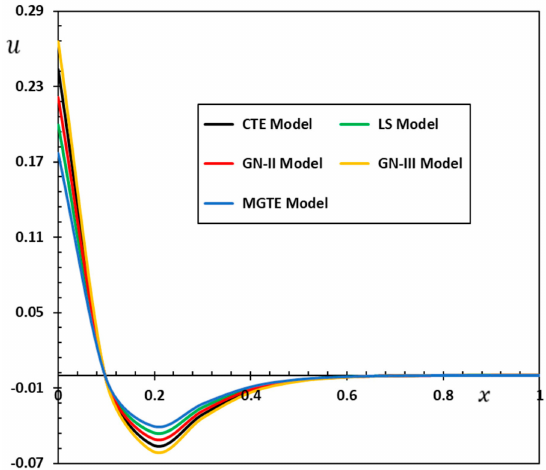
Figure 8. The temperature change θ for various thermoelastic models.